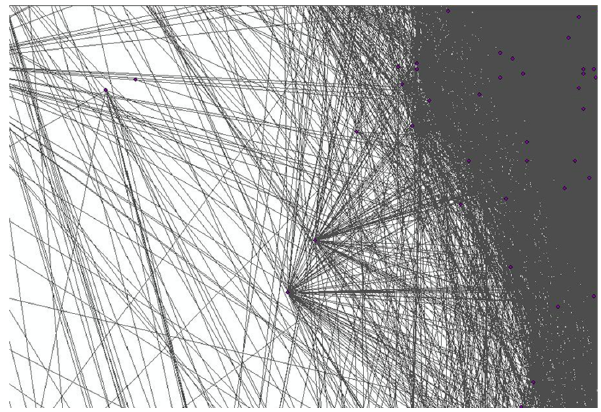
Fig. 2. Zoomed-in example of nodes and edges of the earthquake network presented in Fig. 1.